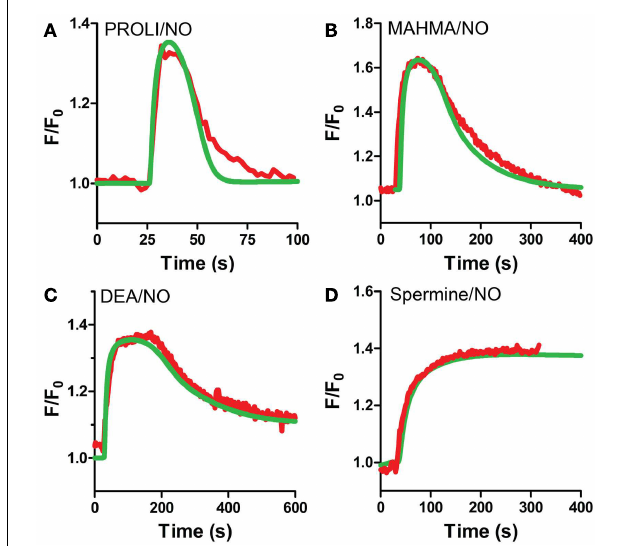
FIGURE 6 |VSM model predicted cGMP traces for multiple NO donors. VSM-specific model predicted cGMP (green) and actual cGMP measured by FlincG (red, averaged traces) after exposure to NO for (A) PROLI/NO, (B) MAHMA/NO, (C) DEA/NO, and (D) Spermine/NO (FlincG traces are mean values from Figures 2 and 3 ).